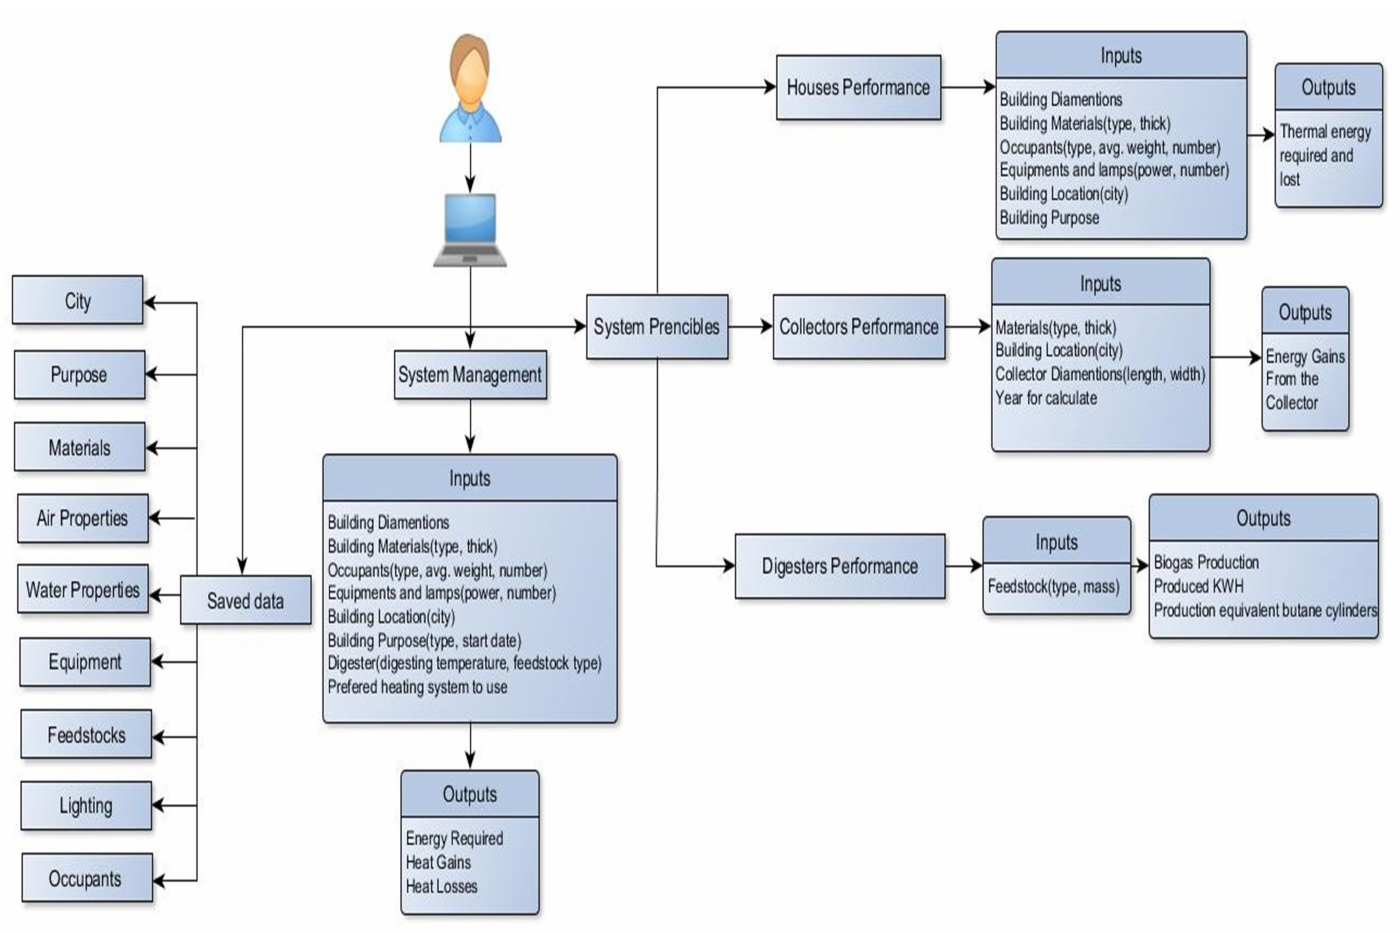
Figure 4. User approach in the model.